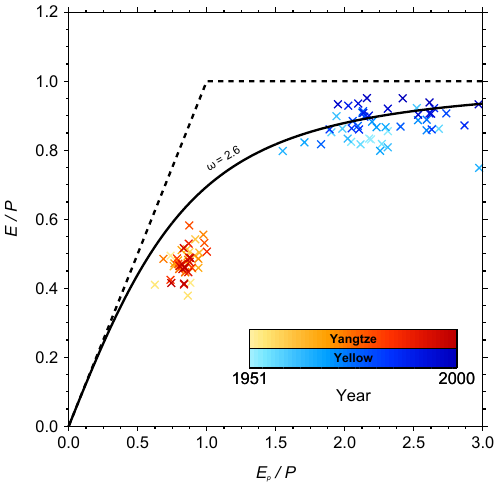
Figure 5. The evaporative index against aridity for the Yangtze (red) and Yellow (blue) River catchments. The symbols represent observed annual mean data for 1951–2000 with darker shades for the more recent years. The traditional Budyko curve is fitted, corre- sponding to ω = 2 . 6 in Eq.